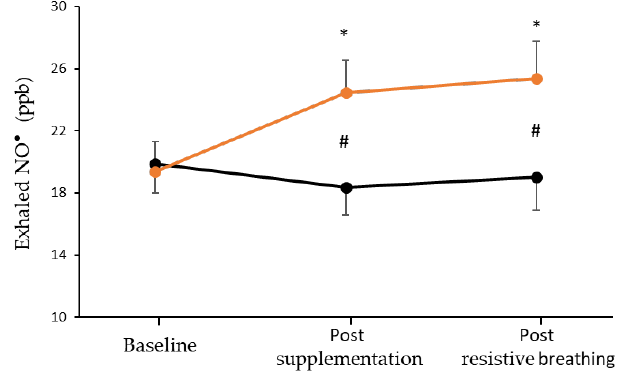
Figure 2. Exhaled NO • at baseline, after seven days of L-citrulline (orange circles) and placebo (black circles) supplementation and post resistive breathing to task failure. (*) indicates significant difference ( p < 0.001) compared to baseline; (#) indicates significant difference ( p < 0.05) between the L-citrulline and placebo conditions.